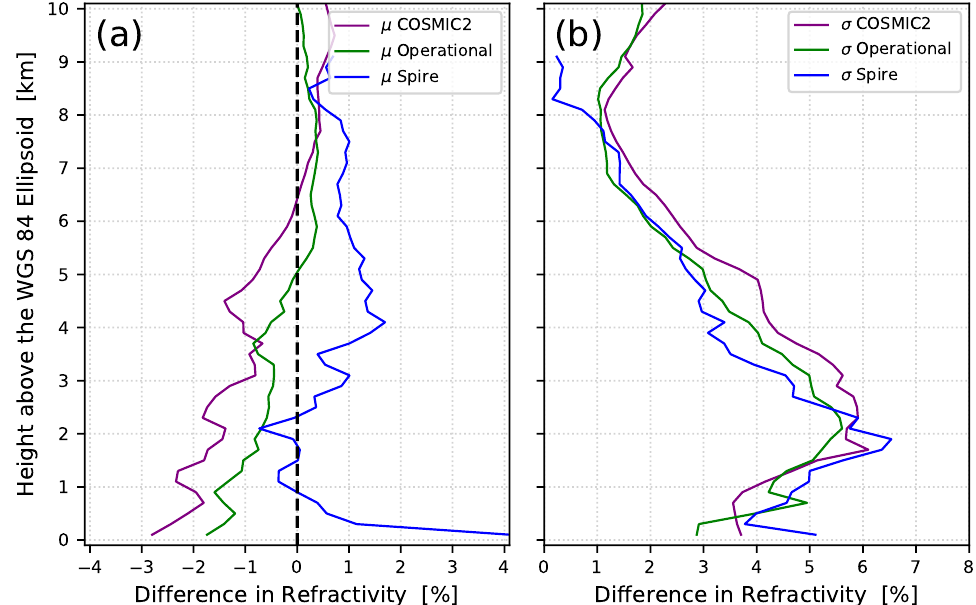
Figure 11. Same as Figure 6 but for occultations and their nearest dropsonde that was within a distance threshold of 500 km and a time threshold of 4